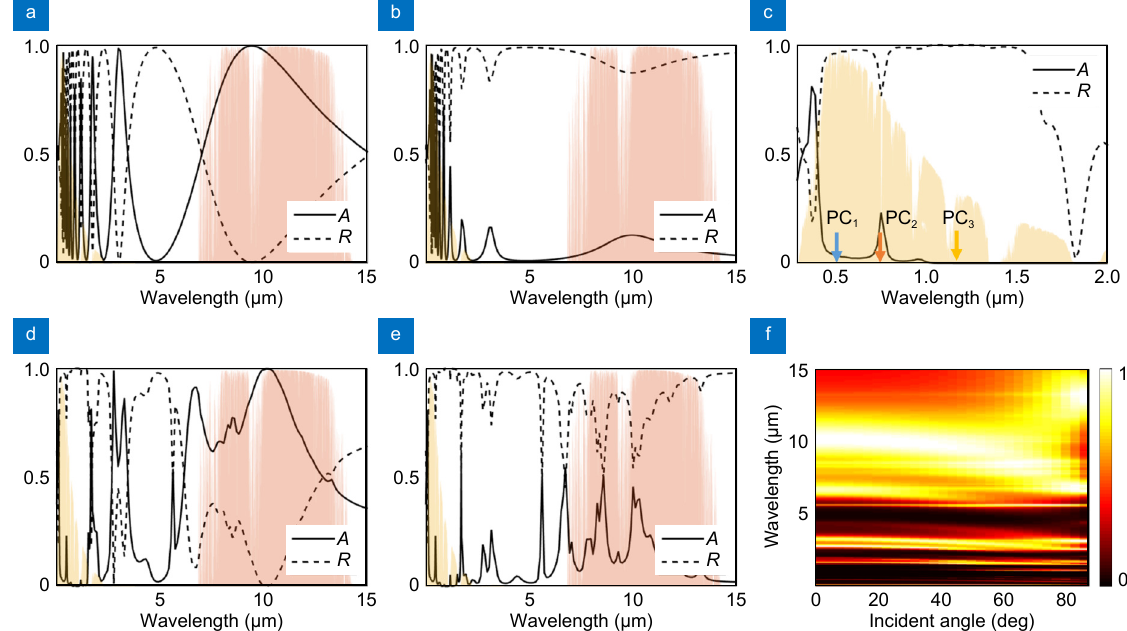
Fig. 3 | Absorptivity and reflectivity of the switchable radiative cooler. ( a , b ) Absorptivity and reflectivity of the emitter part when VO 2 is in (a) metallic and (b) insulating state. ( c ) Absorptivity and reflectivity of the solar reflector part. Three arrows represent the target wavelengths of three photonic crystals. ( d , e ) Absorptivity and reflectivity of the switchable radiative cooler when VO 2 is in (d) metallic and (e) insulating state. Incident angle is zero. ( f ) Absorptivity of the switchable radiative cooler when VO 2 is